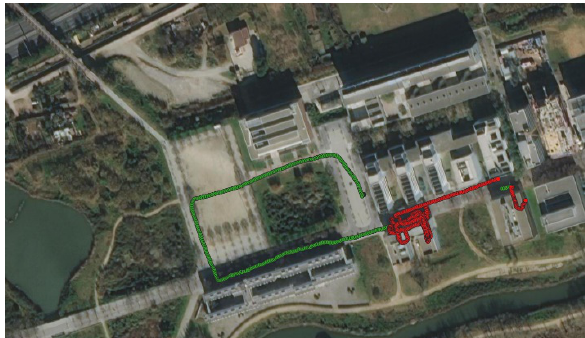
Figure 10 . Estimated “PMT-Buildings” trajectory. Green dots indicate positions provided by the GNSS while red dots are the ones provided by camera-based tracking system.